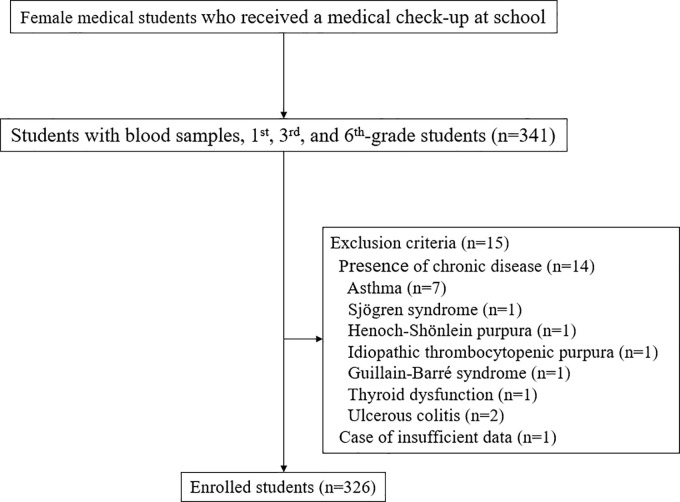
Study flow chart.